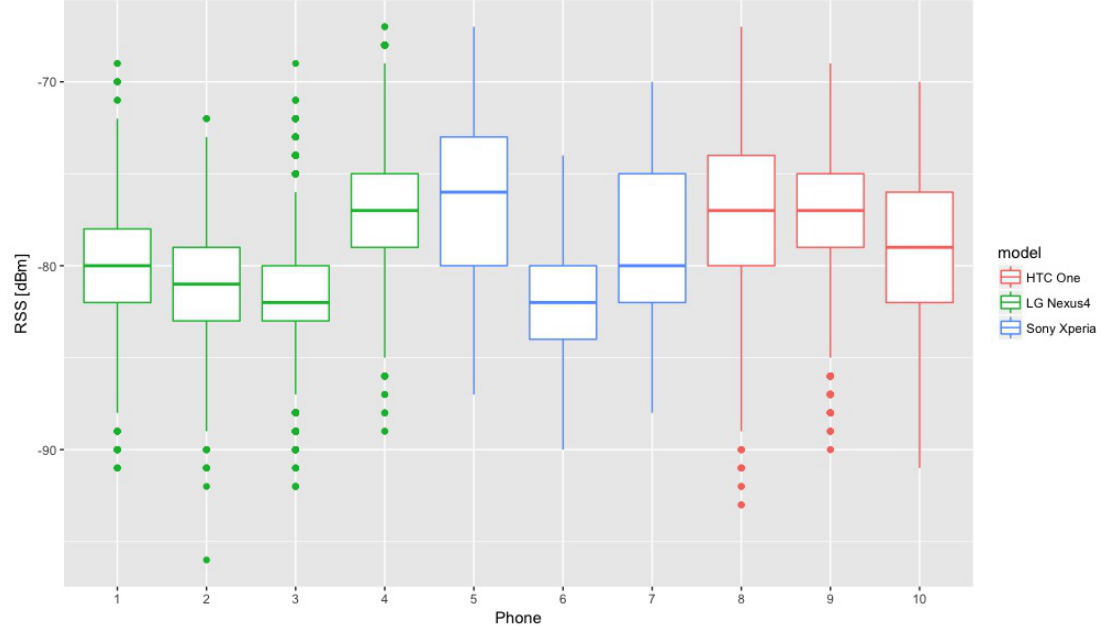
Figure 3. Difference in RSS for various phones and models used in data